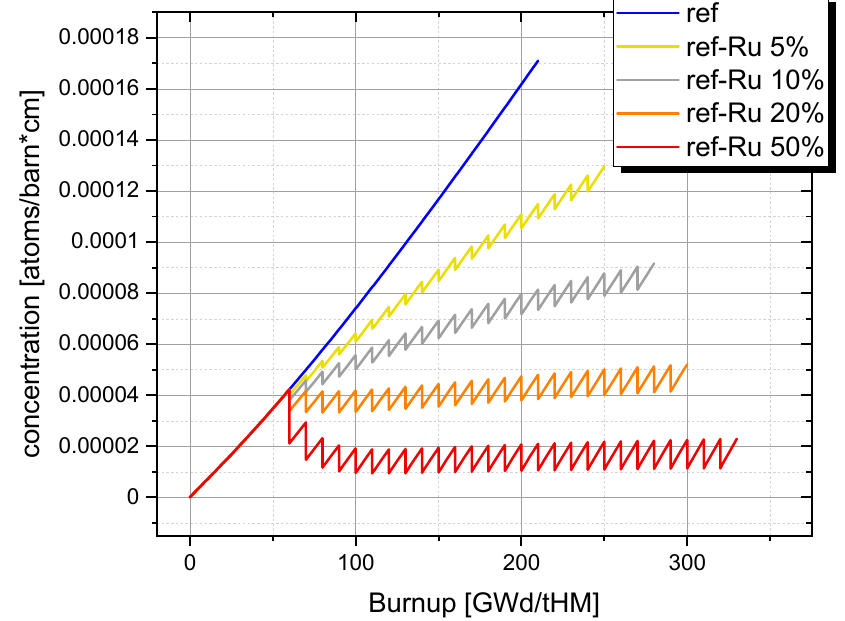
Figure 8. Development of the Ruthenium concentration as produced in HELIOS during the reactor operation investigating the effect of different percentage of the concentration at each step of the calculation.